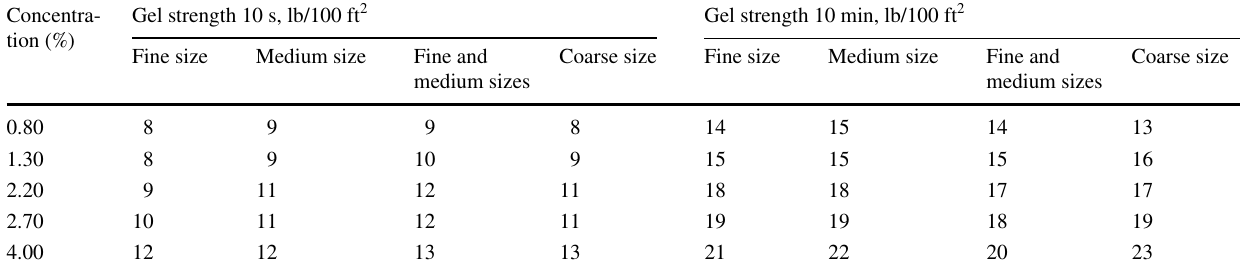
Table 4 Gel strength results for sunflower seed samples Concentra- tion (%)